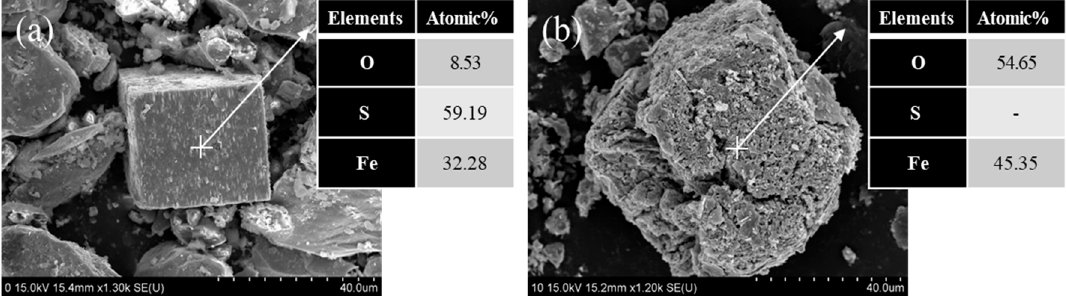
Figure 3. Scanning electron microscope ‐ energy dispersive spectrometer (SEM ‐ EDS) results for pyrite on microwave irradiation time with ( a ) 0 min, ( b ) 10 min.